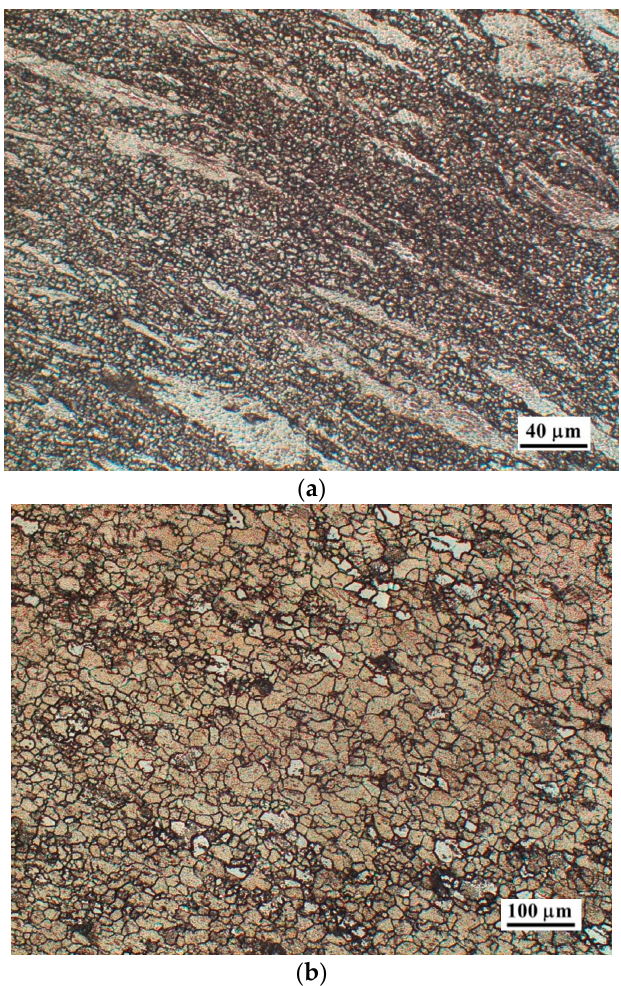
Figure 12. Optical micrographs taken on the specimens forged at conditions ( a ) 300 °C/0.01 mm/s (Corresponding to Domain 1 in the map) and ( b ) at 380 °C/0.01 mm/s (Corresponding to Domain 2). The forging axis is vertical.